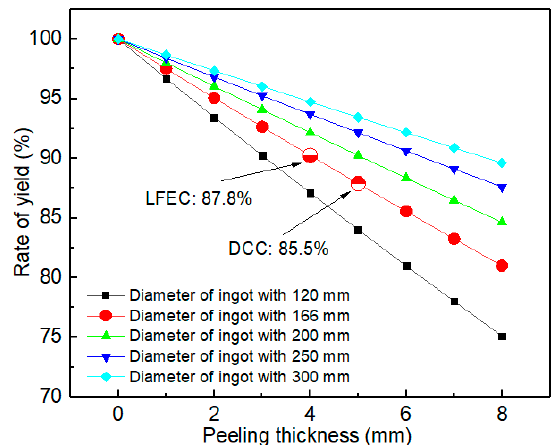
Figure 13. Variation of yield as a function of peeling thickness in the different diameters of the ingot.